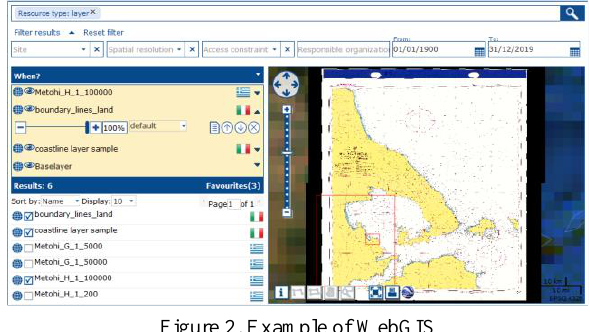
Figure 2. Example of WebGIS